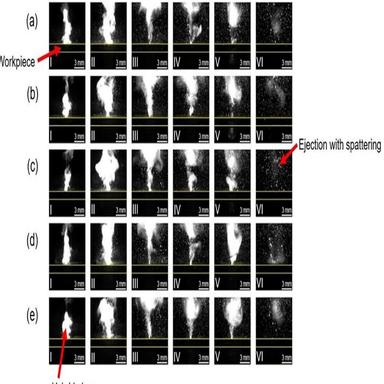
High-speed camera images showing the transient evolution of the through-hole drilling process using a single laser pulse under different water-based ultrasonic powers of (a) 0 W, (b) 156 W, (c) 311 W, (d) 467 W and (e) 622 W.